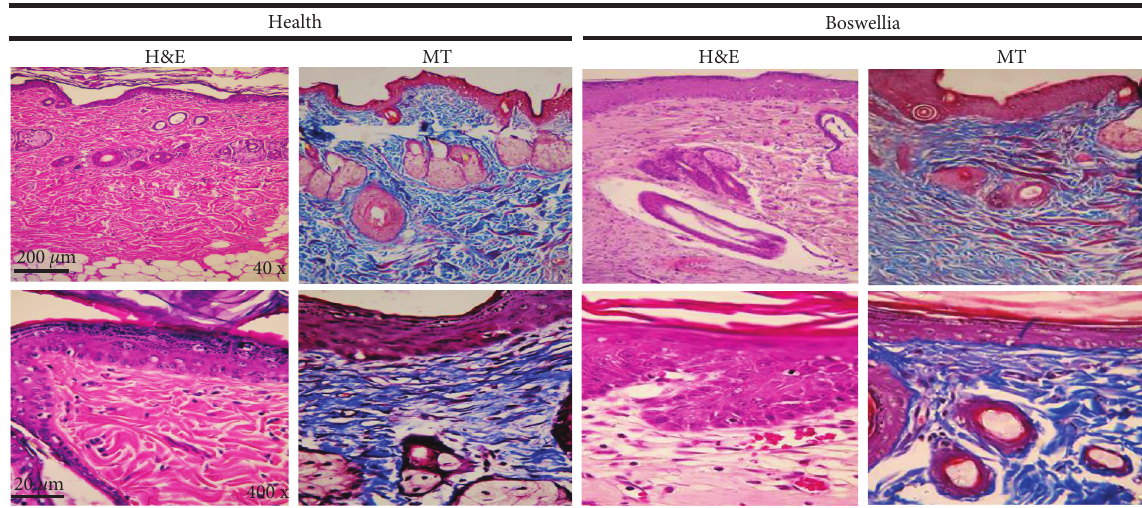
Figure 11: Histopathological images of the skin from the different groups with hematoxylin and eosin (H&E) and Masson ’ s trichrome (MT) staining: healthy group showing normal histological structure and wound group in which intense skin damage can be